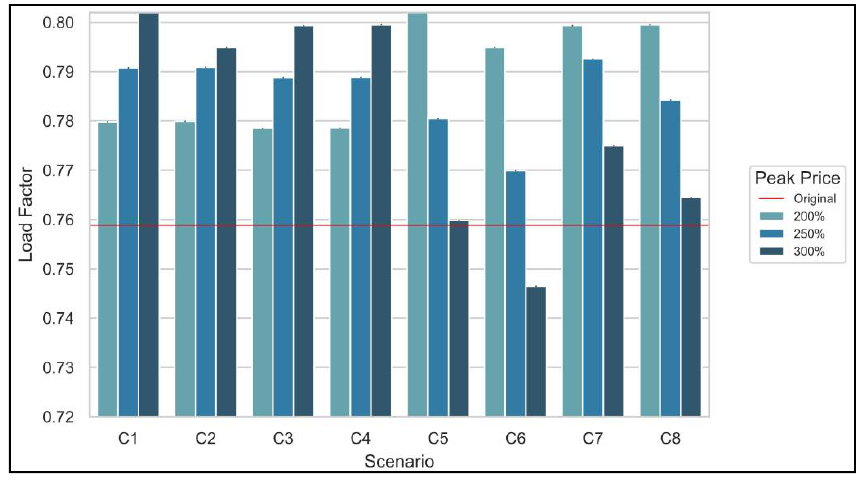
Figure 21. Load factor analysis.